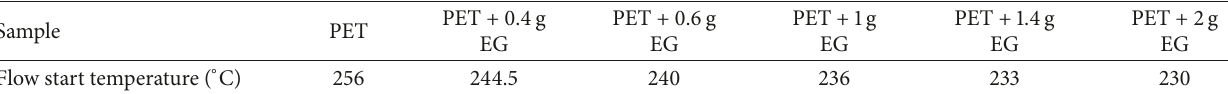
Table 5: Melt flow start temperature for the untreated and EG treated PET